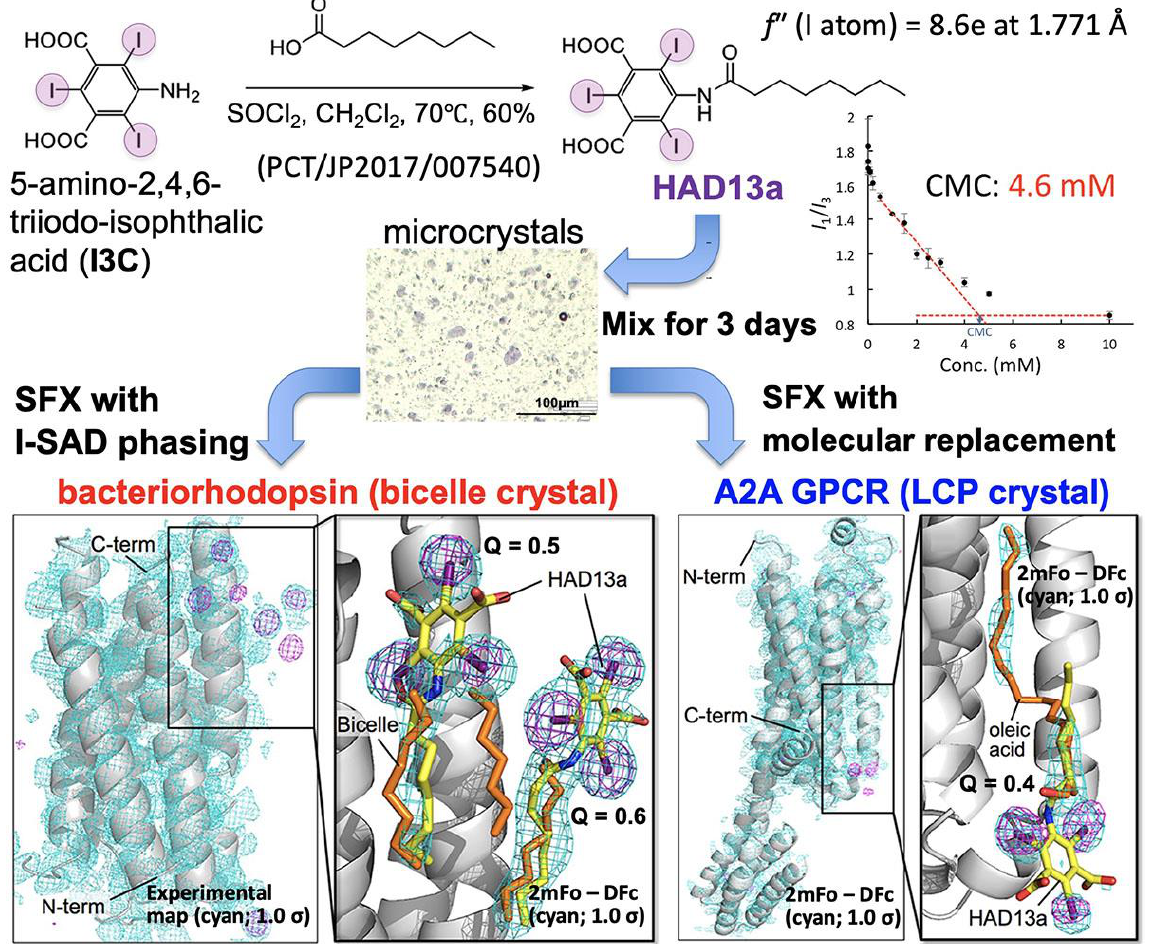
Figure 7. Serial femtosecond crystallography (SFX) of membrane proteins that have interacted with iododetergent, HAD13a. Figure reproduced with modification from Ref. [32].